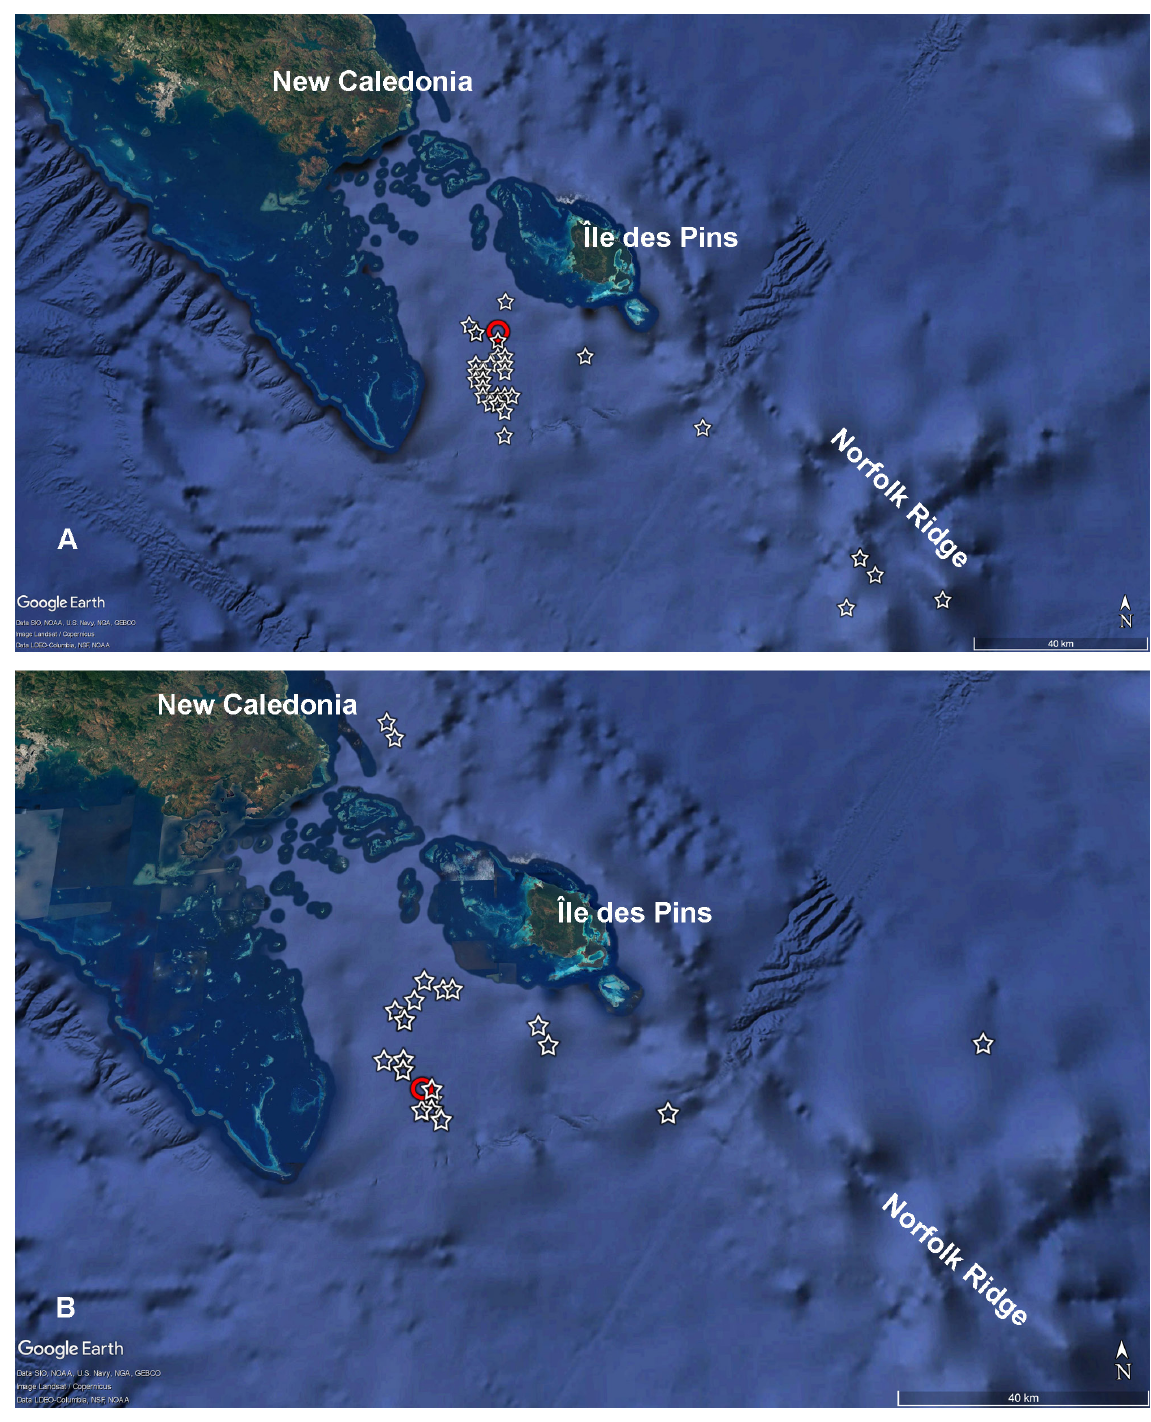
Fig. 9. Distribution map of Amalda aureomarginata Kilburn & Bouchet, 1988 ( A ) and A. fuscolingua Kilburn & Bouchet, 1988 ( B ) off southern New Caledonia. Red circles = the type localities; stars = indicate stations where the species were